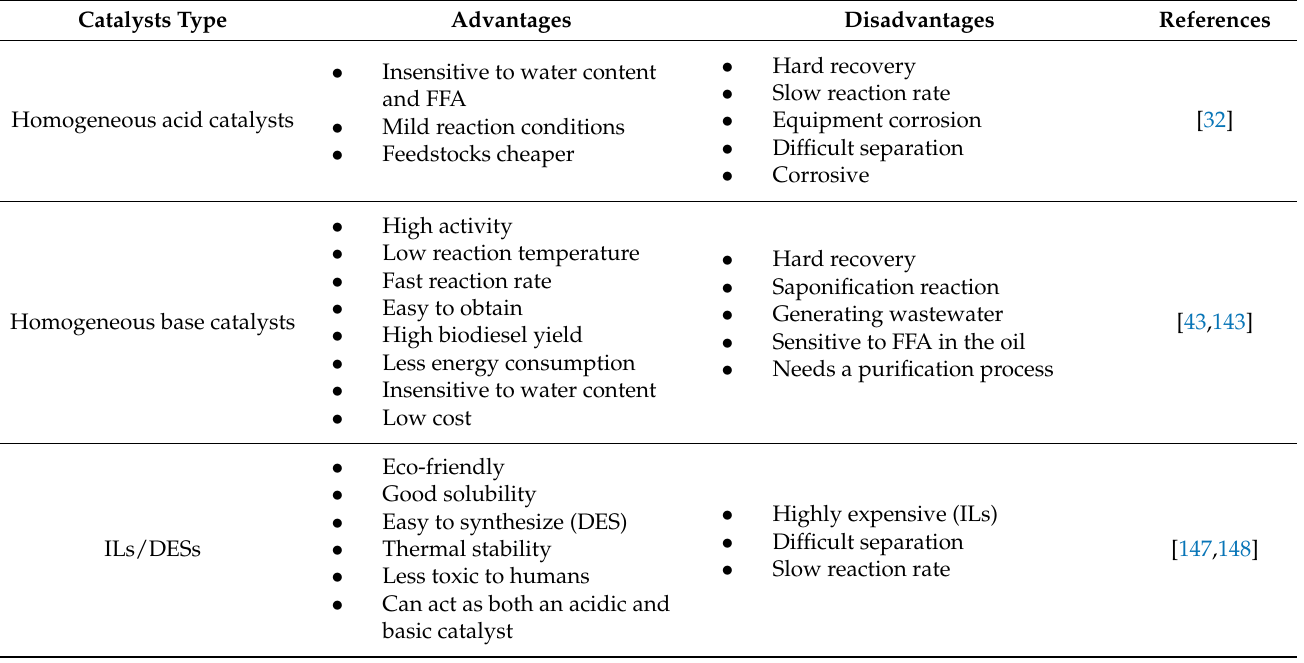
Table 4. The advantages and disadvantages of different catalysts for biodiesel